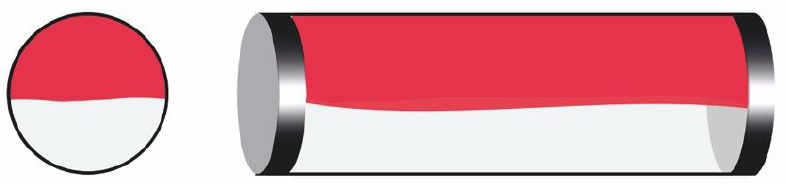
Figure A5. Stratified flow of water and oil. [O & W].